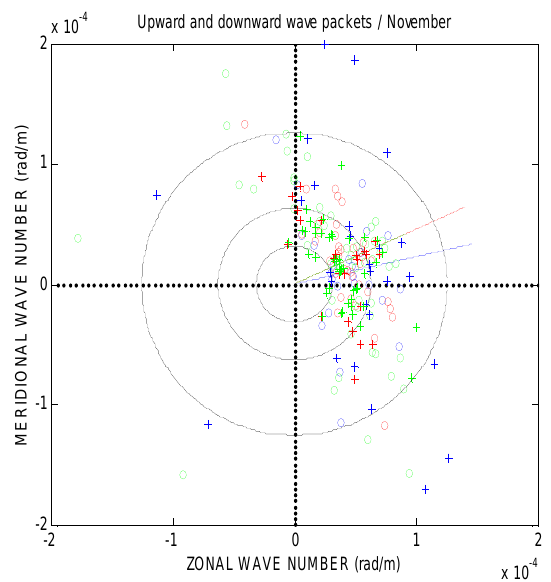
Fig. 7a. Plot of meridional wave number vs. zonal wave number of possible gravity wave packets in the month of November. “o” Fig.7a Plot of meridional wave number .vs. zonal wave number of possible gravity stands for upward, while “ + ” for downward propagating gravity wave packets in the month of November. ‘o’ stands for upward, while ‘+’ for 950 wave packets; blue denotes 1986; red denotes 1988; and green de- downward propagating gravity wave packets; Blue color denotes the year of 1986; notes 1989. Colored lines represent the respective directions (not amplitude) of background mean wind. The inner, middle and outer red color denotes the year of 1988; and green color denotes the year of 1989. black circles correspond to horizontal wavelengths of 200, 100, and Colored straight lines represent the respective directions (not amplitude) of 50km, background mean wind. The inner, middle and outer black circles correspond to horizontal wavelengths of 200, 100, and 50 km respectively. 955